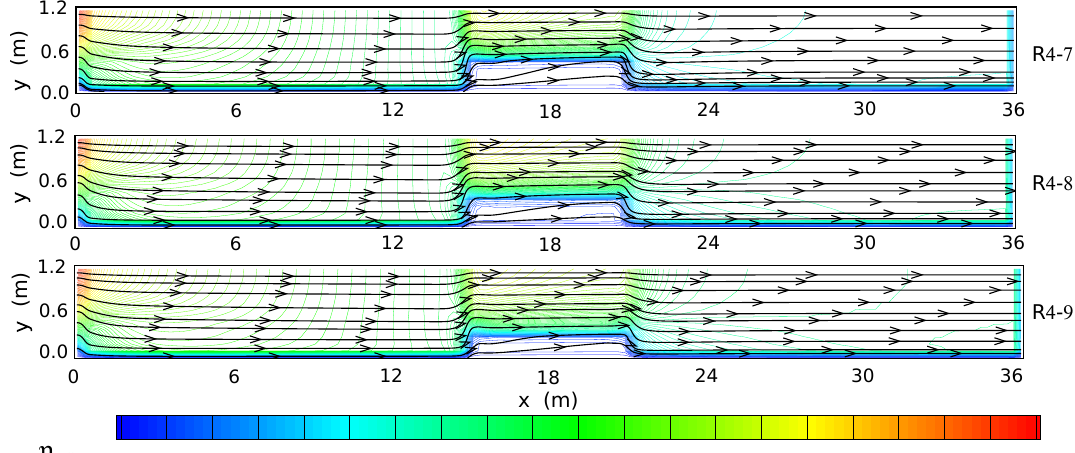
Figure 9. U velocity component and streamlines along the longitudinal mid-plane for the = U/U three cases, where u adim max